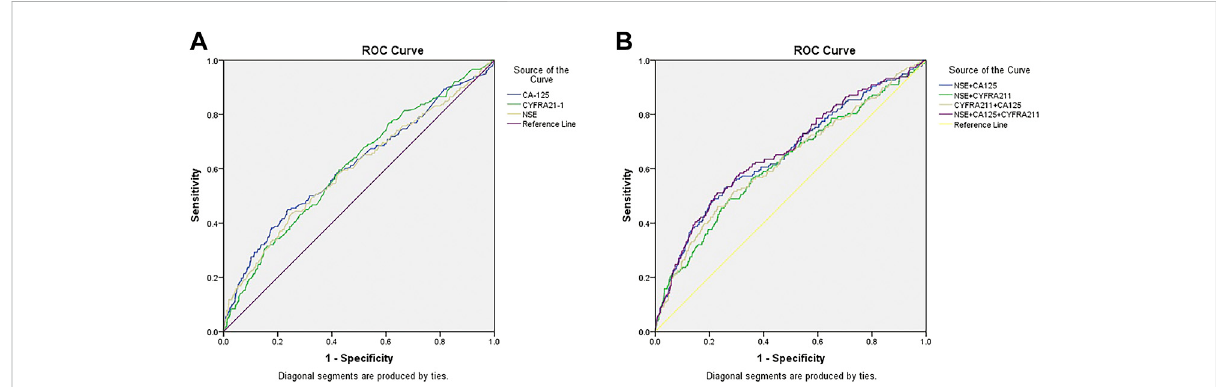
FIGURE 3 The receiver operating characteristics (ROC) curves of risk factor CA-125, CYFRA21-1, and NSE for detecting elderly lung cancer patients with livermetastasis.ROCcurveofthelevelsof[3CA-125,CYFRA21-1,andNSEinelderlypatientswithlivermetastasisoflungcancer (A) .ROCcurveofthe